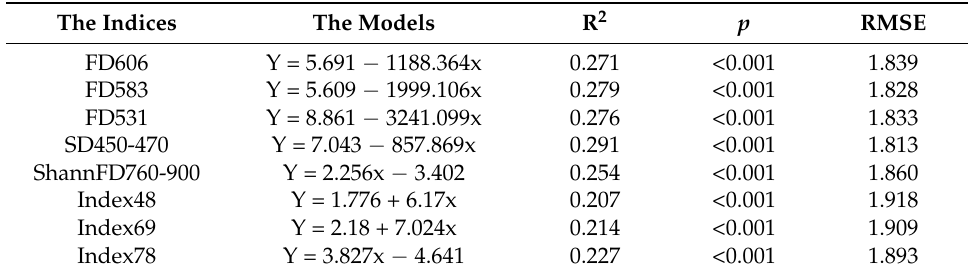
Table 3. Selected hyperspectral indices, models, and parameters in estimating plant species richness based on the training dataset.